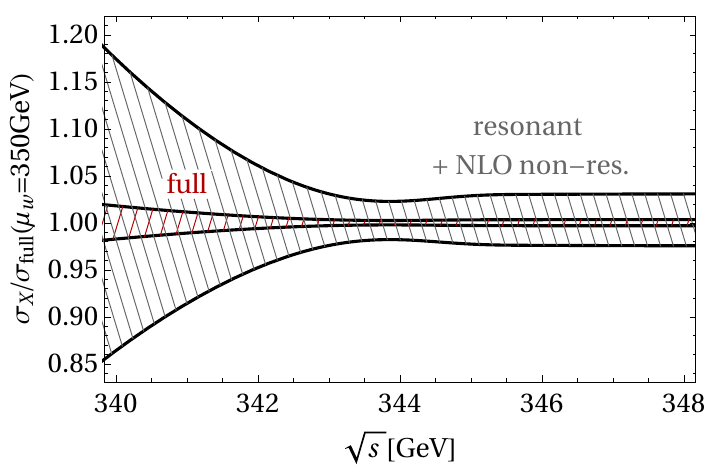
Figure 13 . The resonant plus NLO non-resonant (grey hatched band) and full cross section (red hatched band) are shown for (cid:22) r = 80 GeV. The bands are the envelope of the values obtained by varying (cid:22) w between 20 and 700 GeV. The results have been normalized to the full cross section for the central scale (cid:22) w = 350